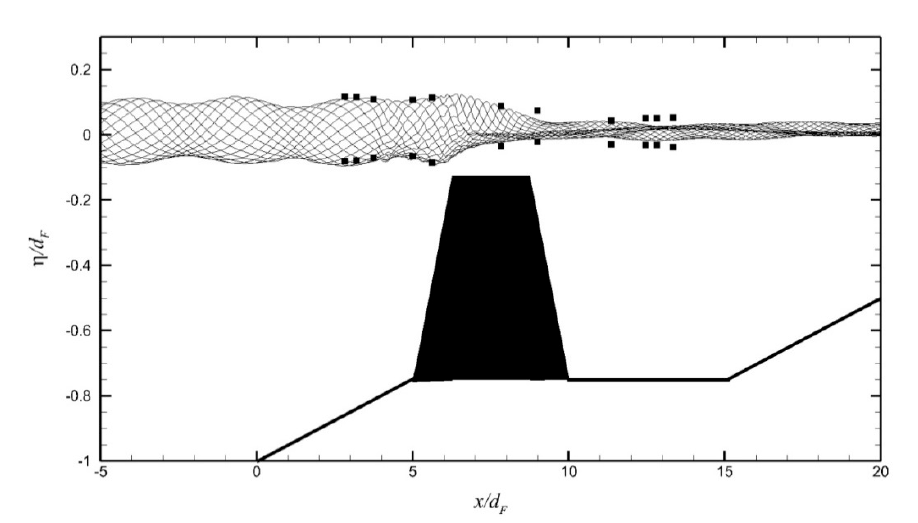
Figure 3. Sketch of the computational domain and part of the Cartesian grid, as well as definitions of the parameters for the numerical simulation of wave propagation over submerged permeable breakwater [13]. Note that the axes are not to scale. The distance from the wavemaker to the toe of the 1/20 slope is 19.3 d F , while the distance from the leeward toe of the breakwater to the toe of the absorbing beach is 4.5 d F .